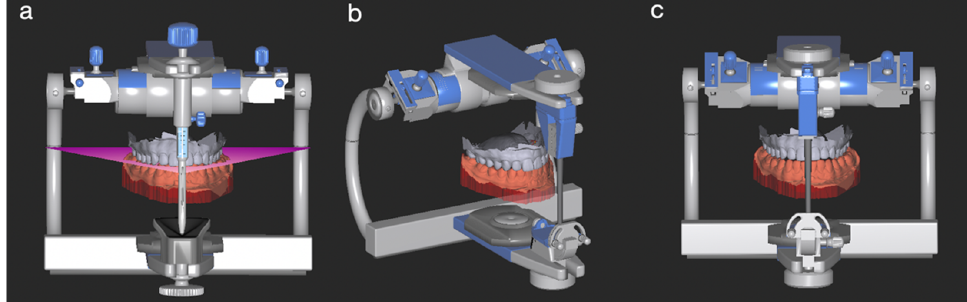
Figure 2. Virtual articulation of the average mounting group (AMG) in the Exocad CAD ® software (v3.0). ( a ) MIP, frontal view. ( b ) MIP, 45-degree view. ( c ) Virtual incisal pin raised by 3 mm.